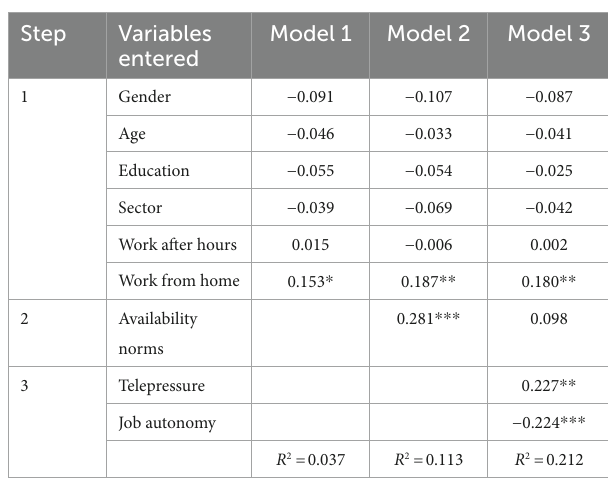
TABLE 3 Multiple linear regression of Burnout symptoms on predictor variables.